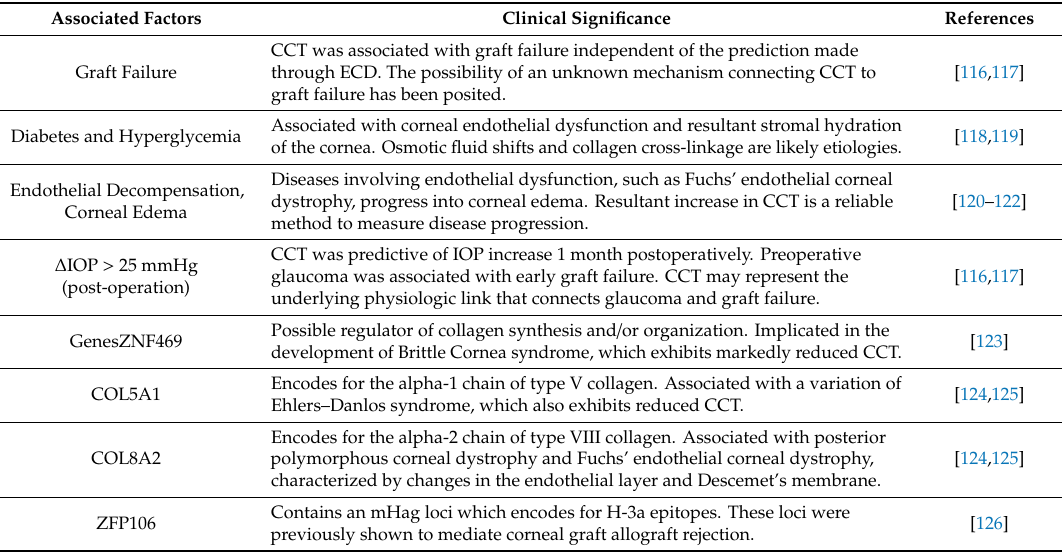
Table 4. Clinical factors and gene loci associated with